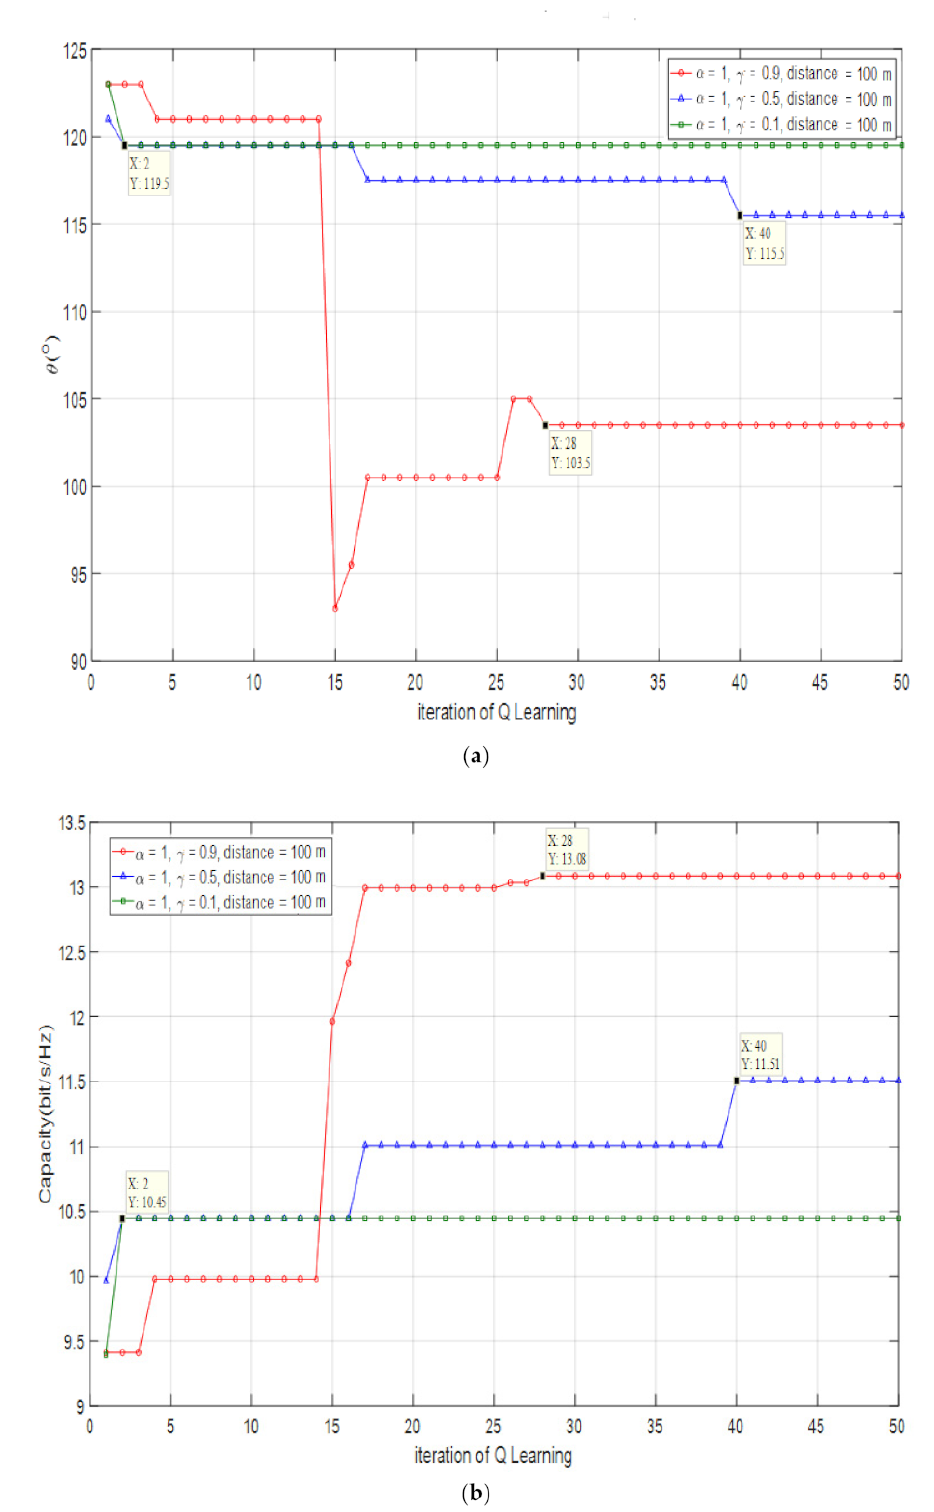
Figure 9. ( a ) Optimized antenna downtilt angle; ( b ) optimized channel capacity. D = 100 m, α = 1 with different γ